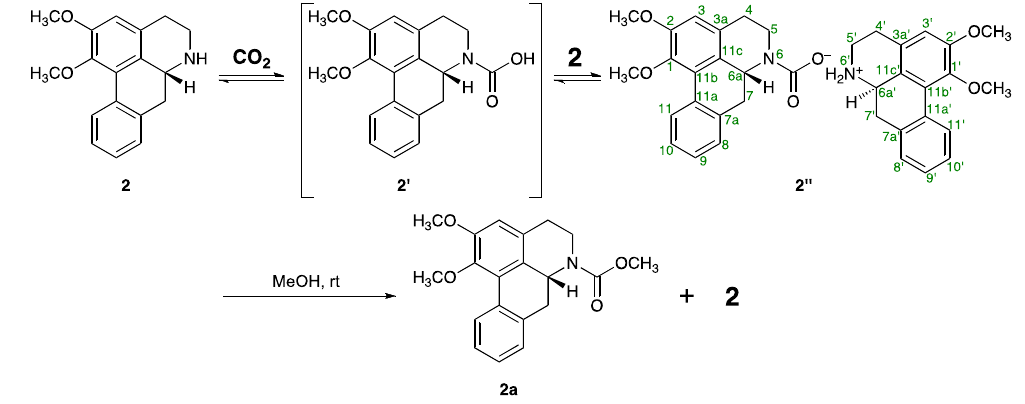
Figure 3. Chemical transformation of nornuciferine ( 2 ) into its ammonium carbamate salt ( 2 ′′ ) and to methyl carbamate ( 2a ).